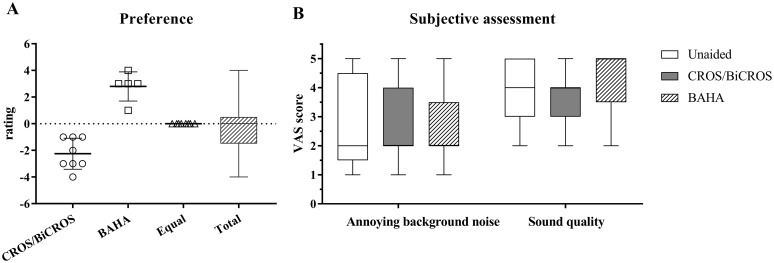
Subjective assessments.Panel A shows the study participant preferences for wireless CROS/BiCROS and soft-band BAHA. Panel B shows a six-item VAS for assessing background noise and sound quality in the three listening conditions. A higher score indicates that the sound was perceived better.